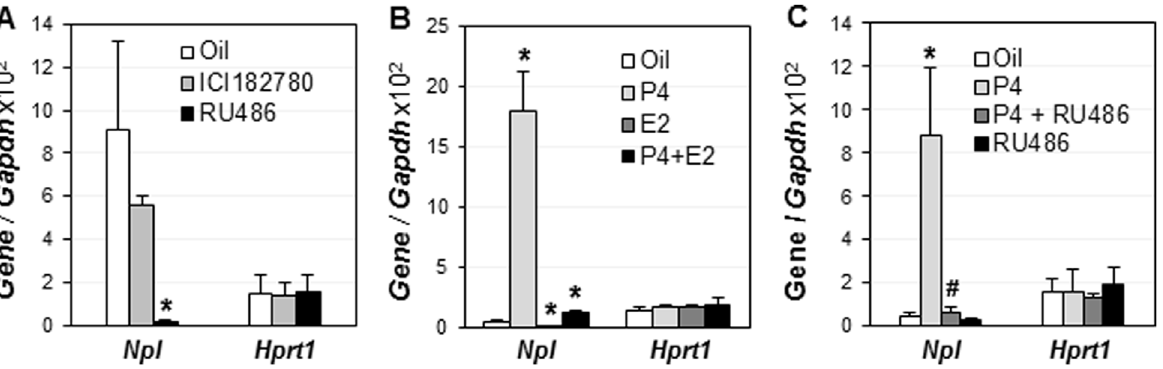
Figure 2. Hormone regulation of Npl in preimplantation and ovariectomized wild type mouse uterus using realtime PCR. A. Expression of Npl in the preimplantation uterus treated with estrogen receptor antagonist ICI 182780 or progesterone receptor antagonist RU486 (N=3–4). B. Regulation of Npl by progesterone (P4) and 17 b -estradiol (E2) in ovariectomized uterus (N=4–6). * p , 0.05, compared to oil-treated group. C. Effect of RU486 on P4 induced uterine Npl expression in ovariectomized mice (N=4–5). * p , 0.05, compared to oil-treated group; # p , 0.05, compared to P4 treated group; Gapdh (glyceraldehyde 3-phosphate dehydrogenase), a house keeping gene as a loading control; Hprt1 (hypoxanthine phosphoribosyltransferase 1), another house keeping gene; error bars, standard deviation.